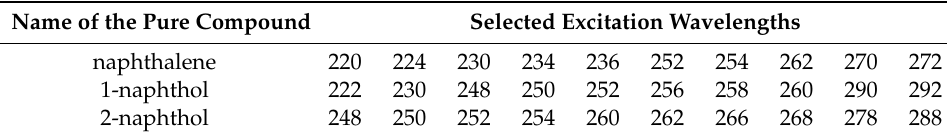
Table 3. The selected excitation wavelengths for the pure compound (nm).